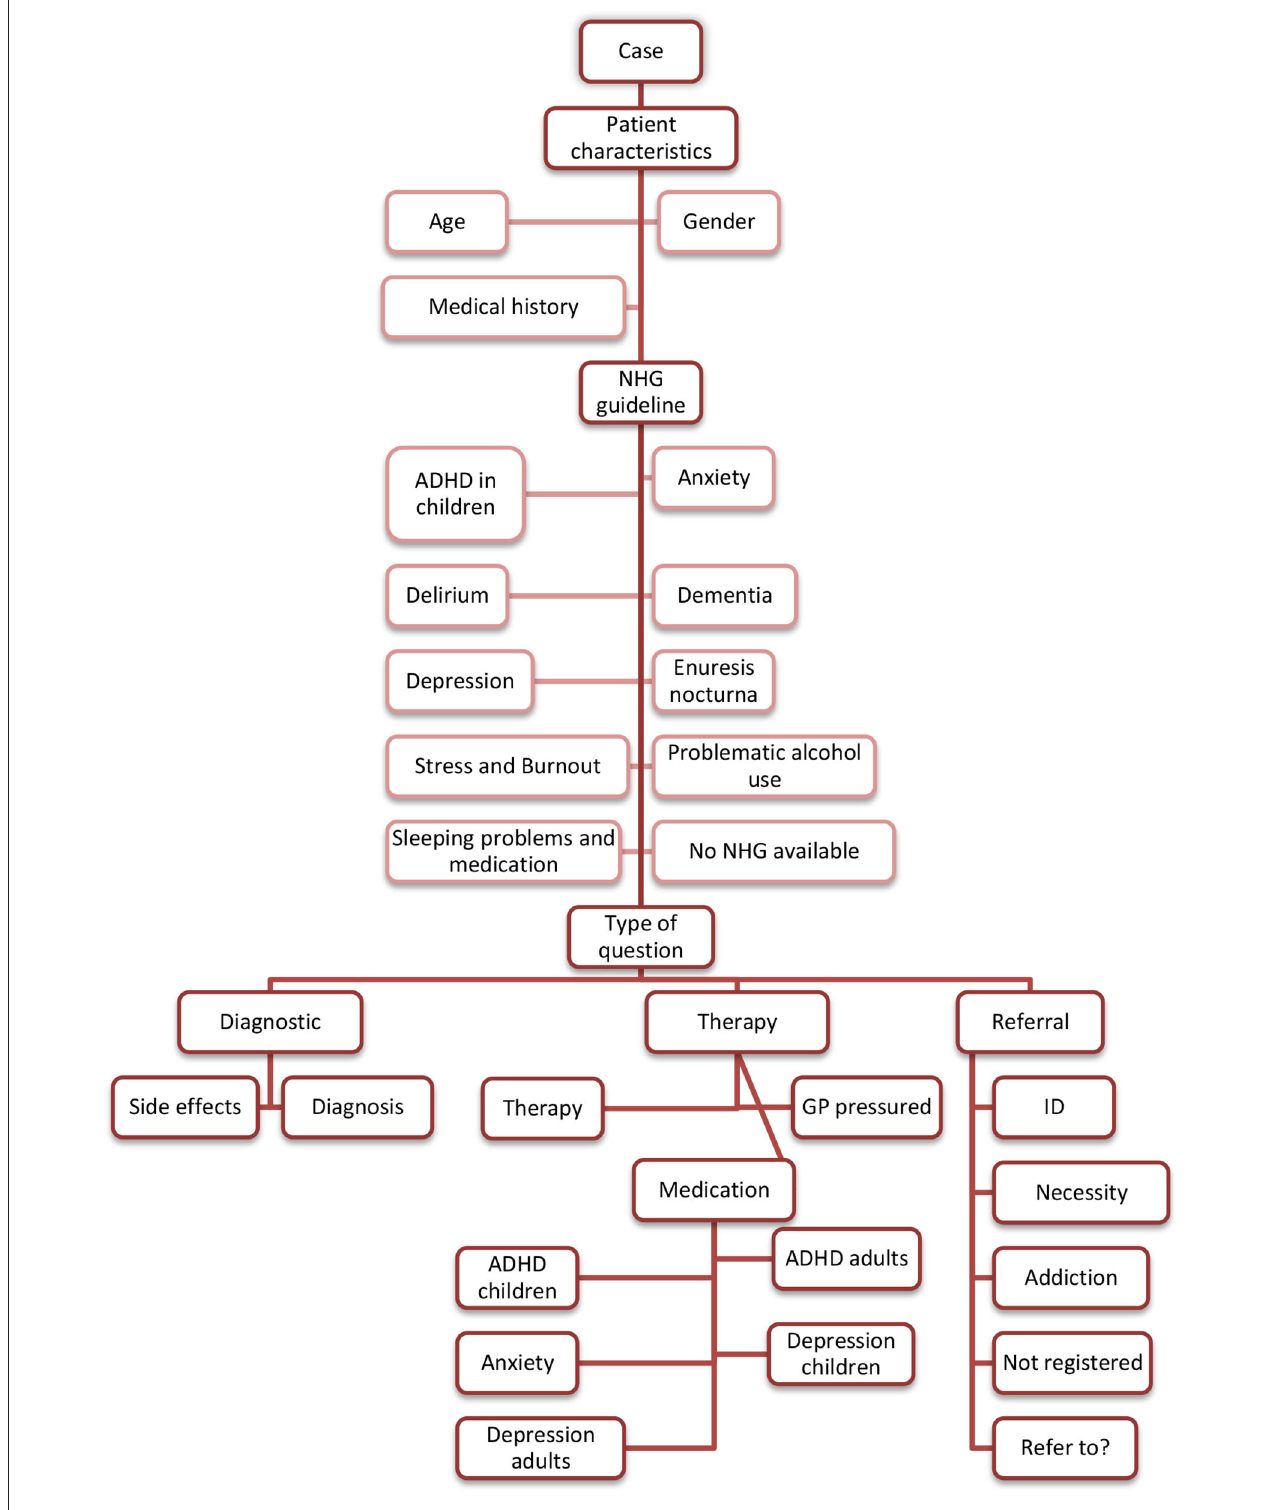
FIGURE 1 | Coding tree. The presented overview does not include codes that did not lead to a theme. ADHD, Attention deficit/hyperactivity disorder; GP, general practitioner; ID, intellectual disability NHG, Nederlands Huisartsen Genootschap (Dutch College of General Practitioners).